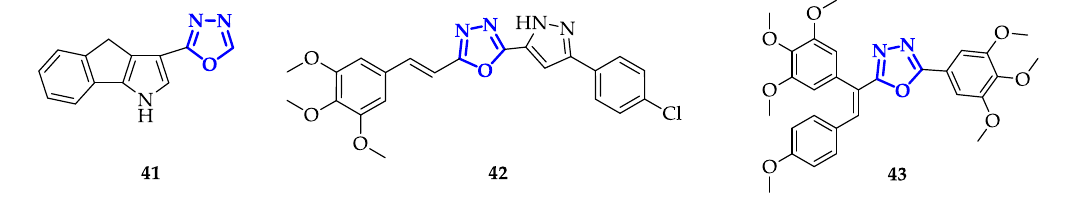
Figure 8. Oxadiazoles as tubulin inhibitors.